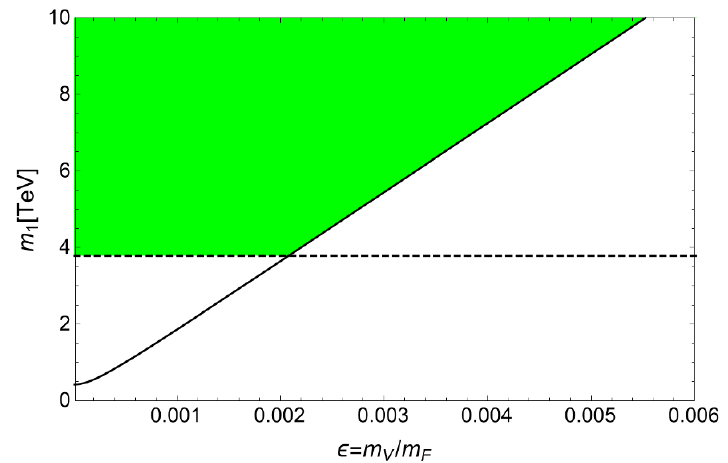
Figure 3 . The lower bounds on the 1st KK gluon mass ( m 1 ) from the meson oscillation data (diagonal solid line) and the LHC Run-2 results (horizontal dashed lines) as a function of (cid:15) = m V =m F . Combining the two constraints, the allowed region is identi(cid:12)ed as the green shaded